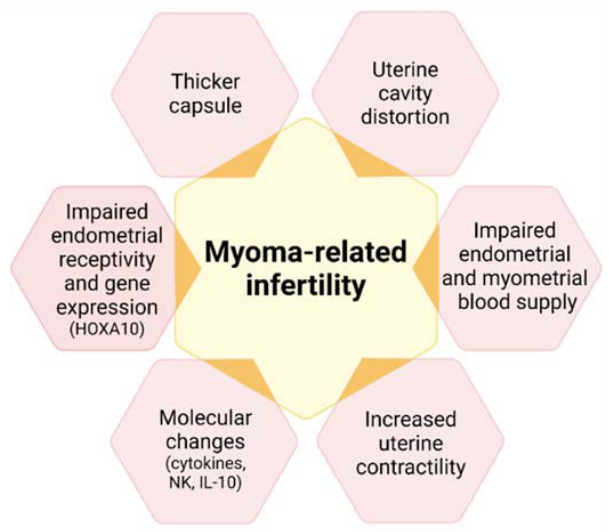
Figure 4. Mechanisms associating uterine fibroids with infertility. HOXA10: homebox A10; NK: nat ‐ ural killer; Il ‐ 10: interleukin 10.